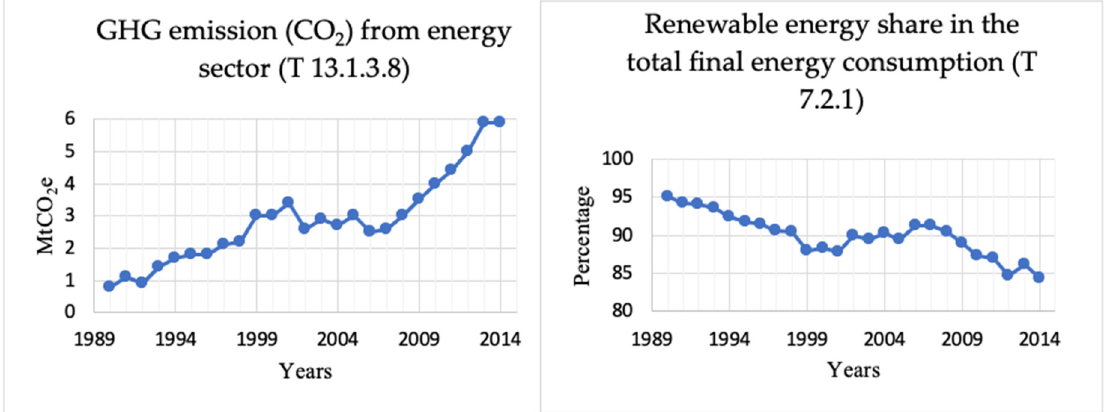
Figure 11. GHG emission (CO 2 ) from energy sector (% change) ( left ) and Renewable energy share in total final energy consumption ( right ).